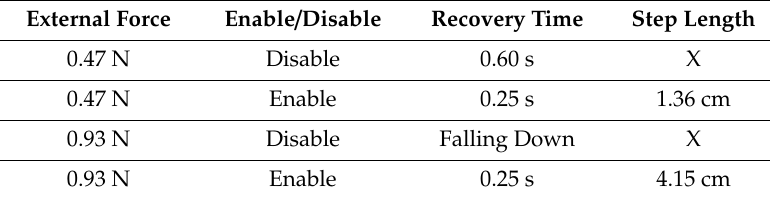
Table 4. Experimental result of the proposed method with the stepping forward is enabled and disabled.